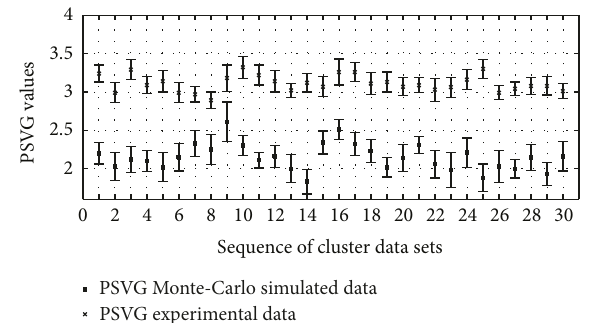
Figure 4: Trend of PSVG values calculated for a specimen set of 30 cluster data sets (both experimental and their MC simulated ones as shown in Tables 1 and 2) extracted from the visibility graph corresponding to one of the four data sets of 𝜙 -values for 32 S-AgBr ( 200 AGeV) interaction data (constructed in step (1) ).